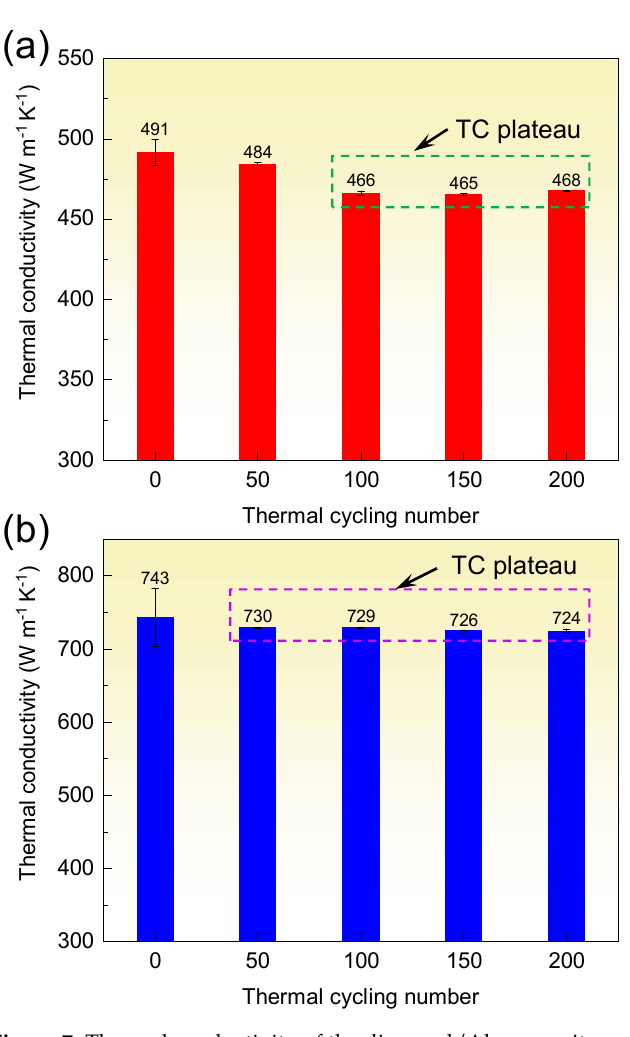
Figure 7. Thermal conductivity of the diamond/Al composites with different diamond particle sizes versus thermal cycle: ( a ) 66 μm and ( b ) 272 μm.